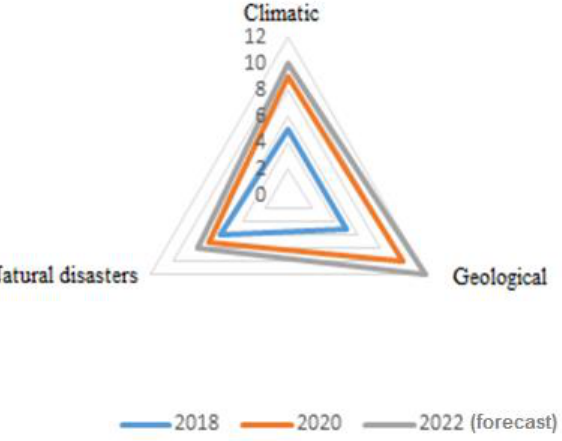
Figure 8. The results of the assessment of the group of natural risks of the enterprises of the cluster. Developed by Leontyev E.